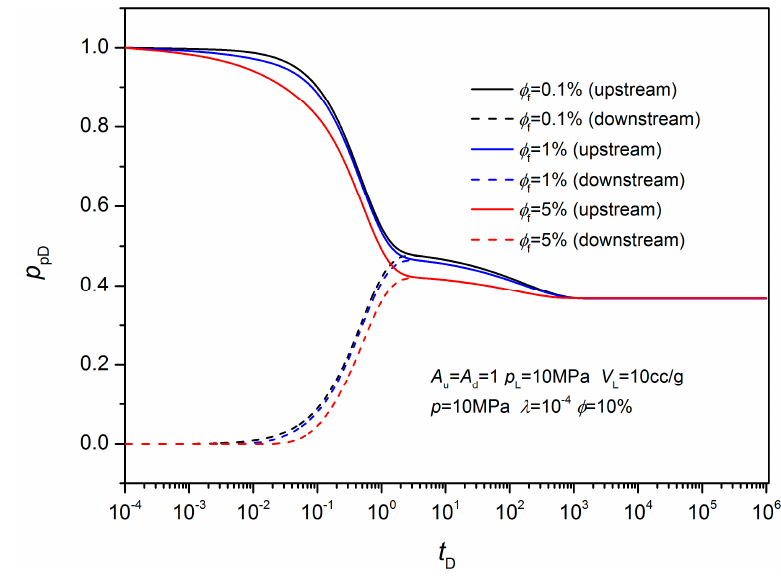
Figure 6. The influence of the fracture porosity on the curve of the non-equilibrium sorption model.